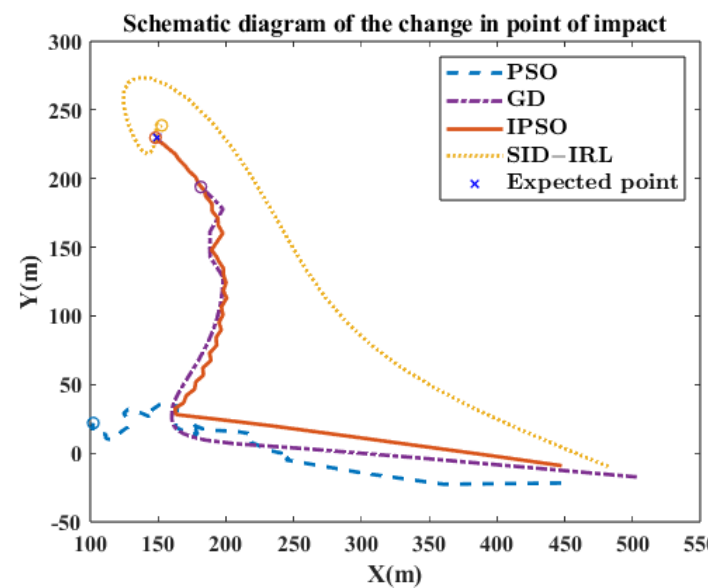
Figure 19. Change of impact point in case